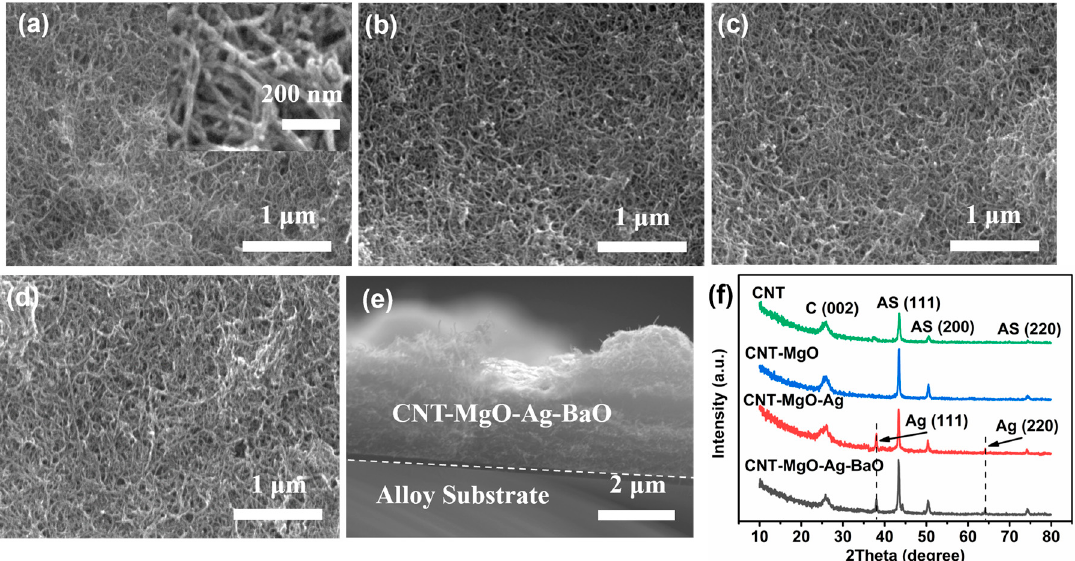
Figure 1. SEM images of the pristine CNTs and CNT-based nanocomposite films. ( a ) The pristine CNTs; ( b ) CNT-MgO composite; ( c ) CNT-MgO-Ag composite; ( d ) CNT-MgO-Ag-BaO composite; ( e ) cross-section of the CNT-MgO-Ag-BaO composite film; ( f ) XRD results of the pristine CNTs and CNT-based nanocomposites.